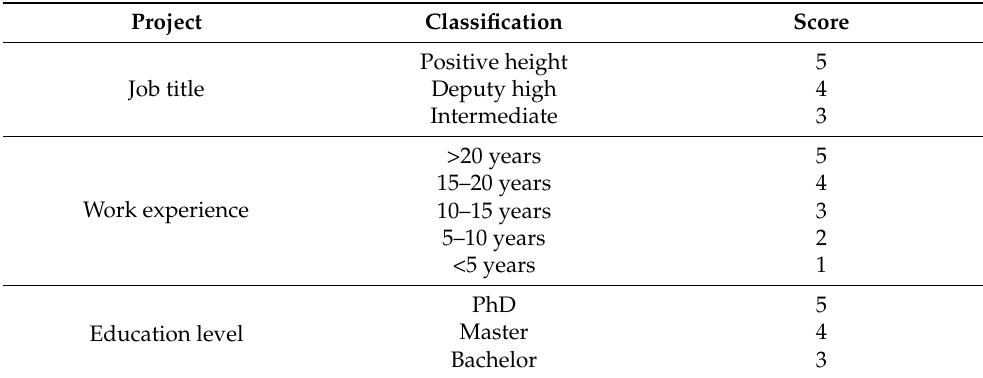
Table 1. Expert importance scoring